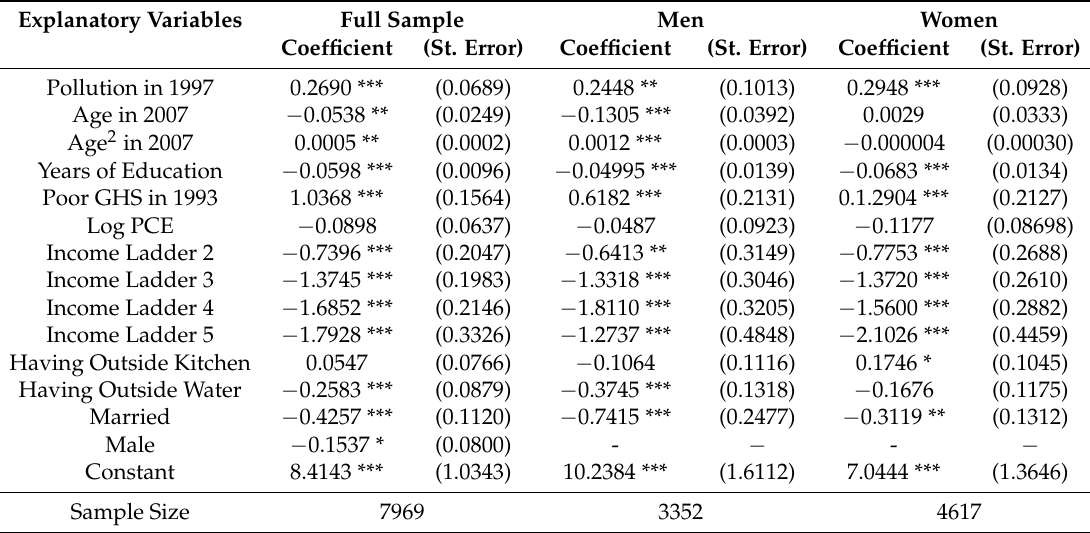
Table 2. The Effects of Pollution on Depressive Symptoms (OLS Regression